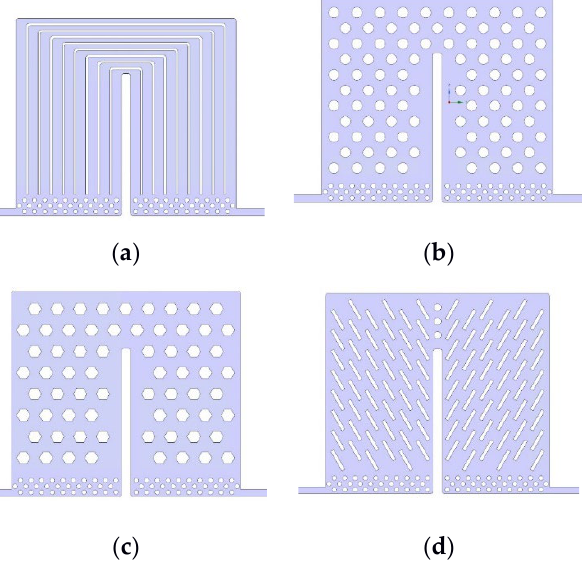
Figure 6. Flow pattern designs ( a ) U-shape, ( b ) convex, ( c ) honeycomb, and ( d )